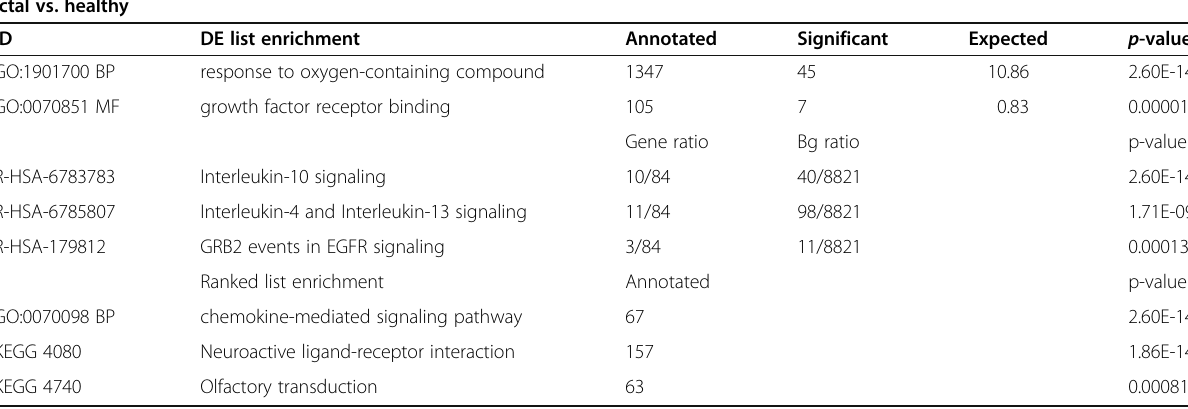
Table 4 Functional enrichment results of PBMC RNA-seq data of the ictal vs. healthy comparison. DE list enrichment: overrepresentation of functional terms in the differentially expressed gene list. Ranked list enrichment: enrichment of genes associated with a certain pathway towards the top of the ranked whole data. GO: gene ontology, BP: biological process, CC: cellular component, MF molecular function. KEGG: Kyoto Encyclopedia of Genes and Genomes. Annotated: number of genes associated with the given term. R: Reactome database. Significant: number of statistically significant associated with the given term. Expected: expected number of genes associated with the given term in the DE gene list. Gene ratio: ratio of number of genes in the DE list that overlap with genes associated with the given term, and the number of genes in the DE list which overlap with genes associated with all terms in the Reactome database. Bg ratio: ratio of the number of genes associated with the given term, and the total number of genes associated with Reactome